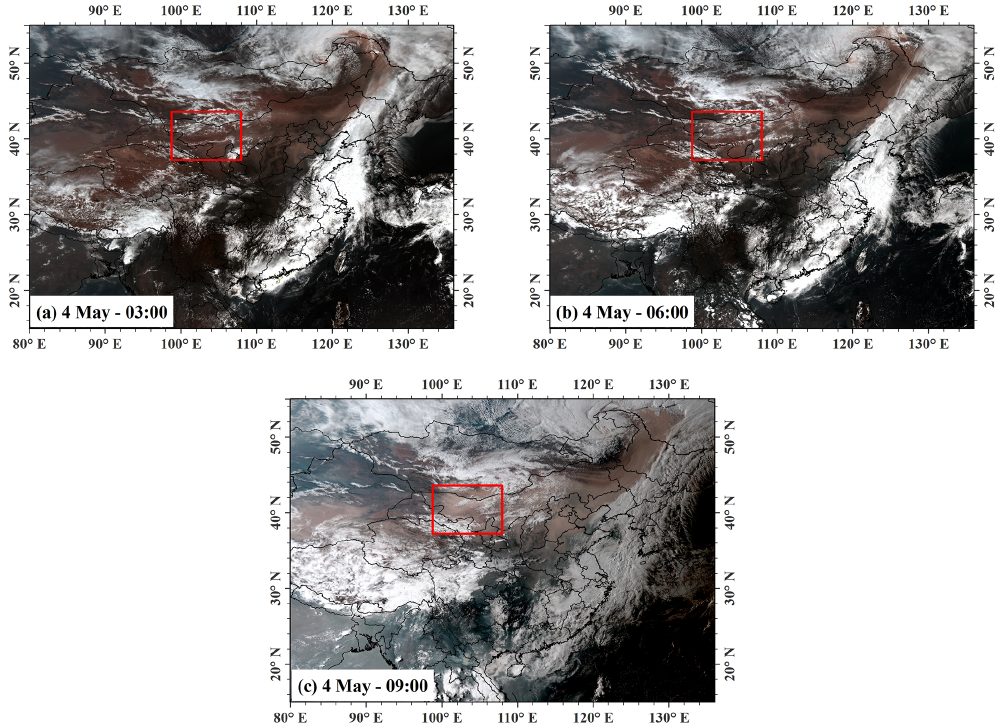
Figure 7. True-colour composite AHI images of mainland China over a 3h interval from 03:00 to 09:00UTC on 4 May 2017: (a) 03:00, (b) 06:00, and (c) 09:00. The red rectangles mark the area where another dust plume originated in the afternoon of 4